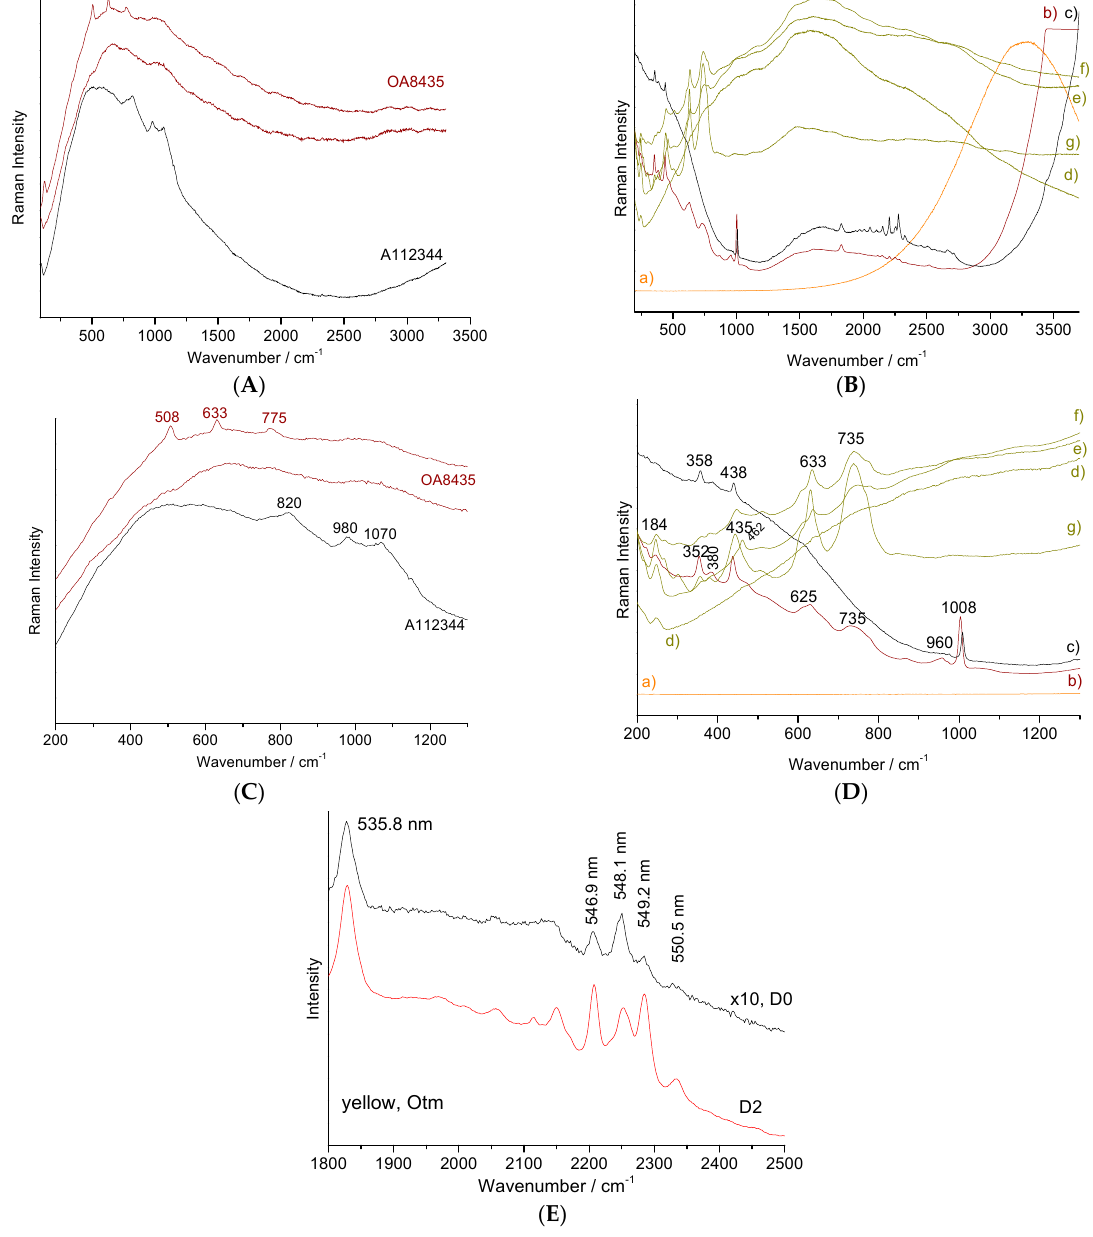
Figure 4. Representative spectra having a strong fluorescence contribution: ( A ), 532 nm laser excitation; red enamel on metal (two spectra, OA8435 18th century watch [15], Louvre Coll.; zoom in ( C ) and on glass (A112344 figure, Orléans City Museum Coll. [18]) obtained with a dispersion of Au° nanoparticles ; ( B ) 457.8 nm excitation (zoom in ( D )): (a), red overglaze on porcelain colored by CdS 1-x Se x ; (b,c) pale yellow glaze on porcelain (Figure 3e, Somi cup); (d–g) yellow glaze on porcelain colored by addition of praseodymium and opacified by addition of cassiterite and yttrium-stabi- lized zirconia. A zoom of (b) and (c) pale yellow glaze in the 1800–2500 cm − 1 range is given in ( E ) (power at the sample, 5 (D0) and 0.05 (D2) mW).